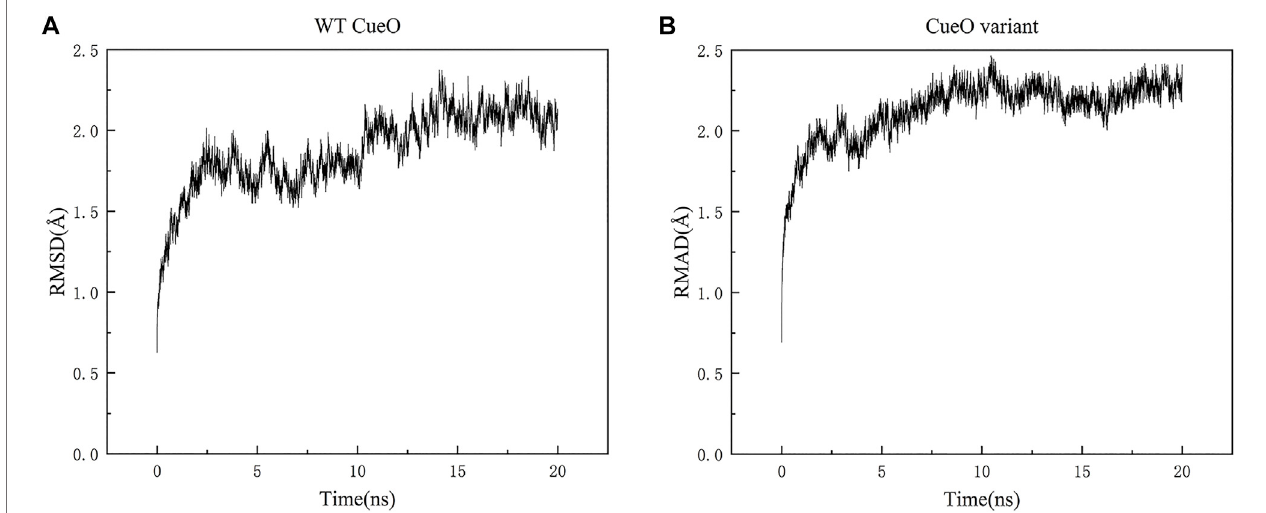
FIGURE 1 | Backbone RMSD for (A) WT CueO and (B) the L502K variant during 20 ns course of the MD simulations.